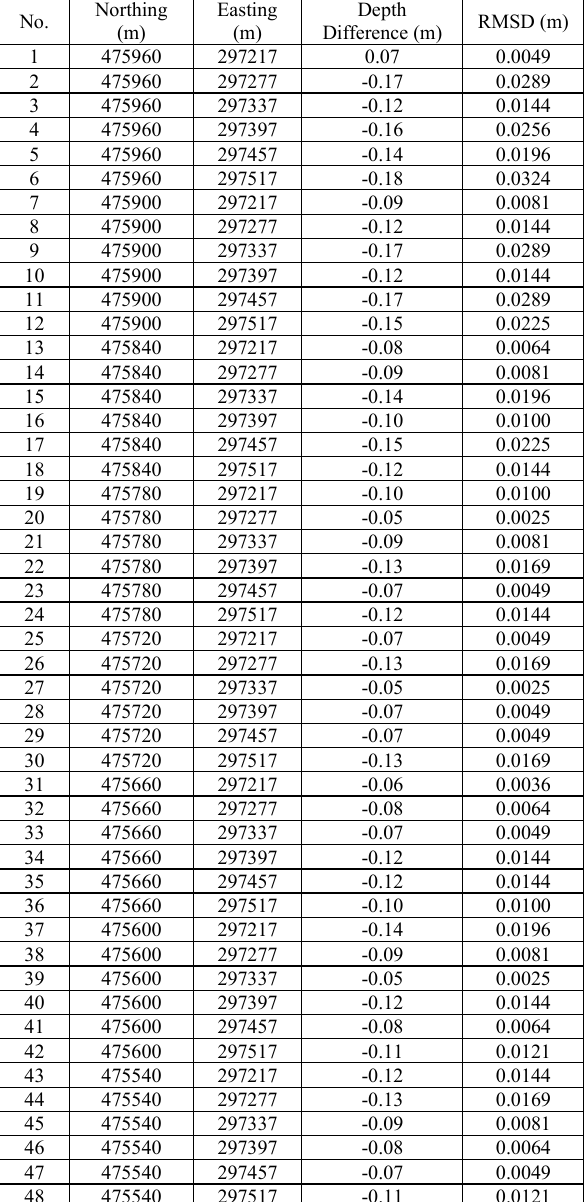
Figure 30. The comparison of depth relative to the on-site and DSMM tide gauge in 2018 Table 10. Minimum bathymetry standard (IHO S-44 Standards for Hydrographic Surveys, 6th